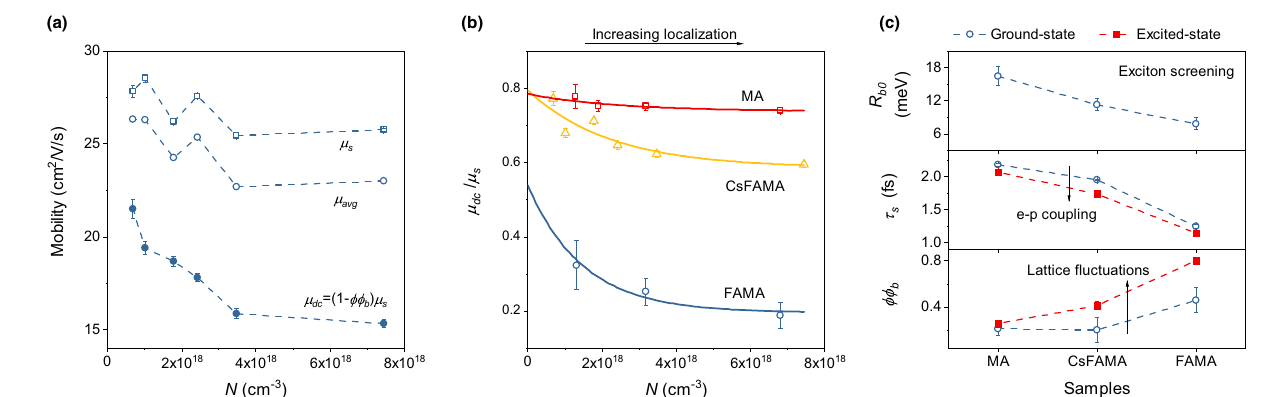
μ dc represents the dc mobility (solid circles). b The